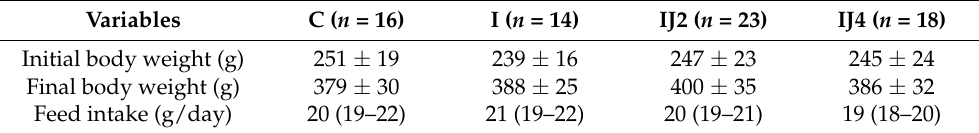
Table 1. Initial and final body weight and daily feed